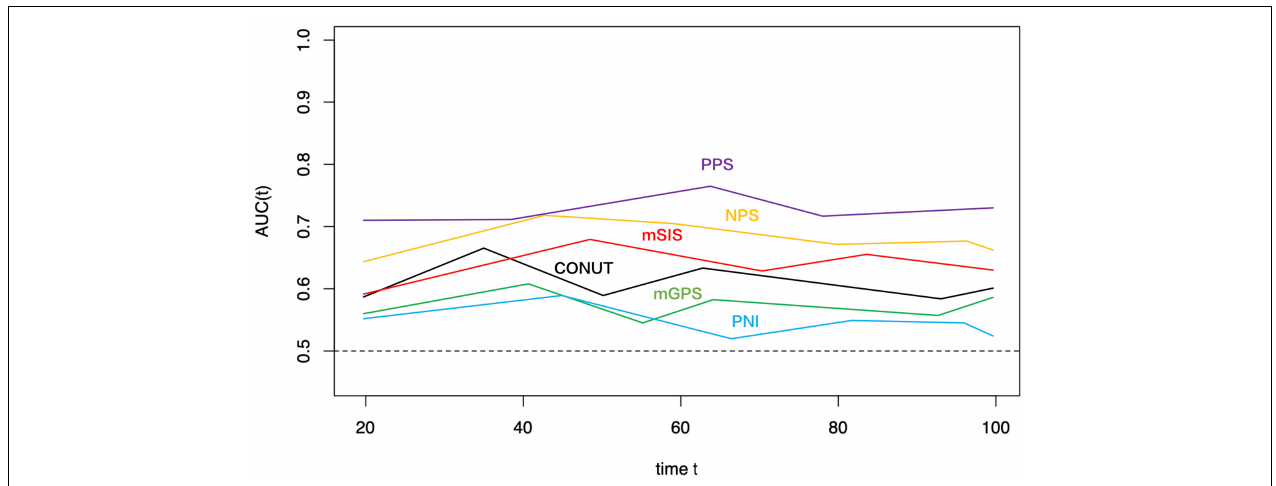
FIGURE 5 | Time-dependent ROC curves of PPS, NPS, mSIS, CONUT, mGPS, and PNI for prediction of over survival. The horizontal axis represents the year after surgery, and the vertical axis represents the estimated AUC for survival at the time of interest. PPS, Peking prognostic score; NPS, Naples prognostic score; mSIS, modified systemic inflammation score; CONUT, controlling nutritional status; PNI, prognostic nutritional index; and mGPS, modified Glasgow prognostic